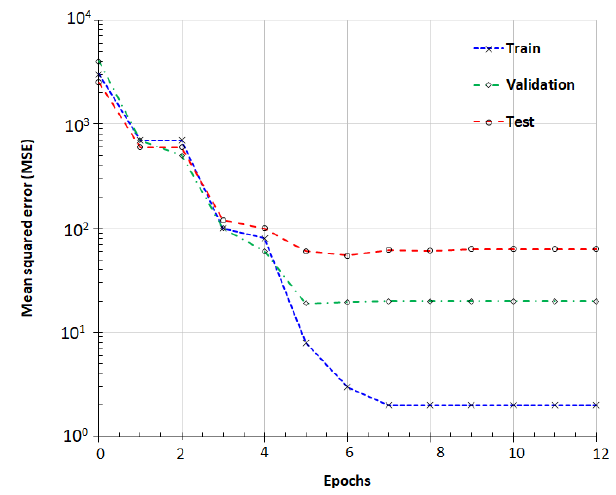
Figure 7. Model performance plot based on mean squared error (MSE) analysis.